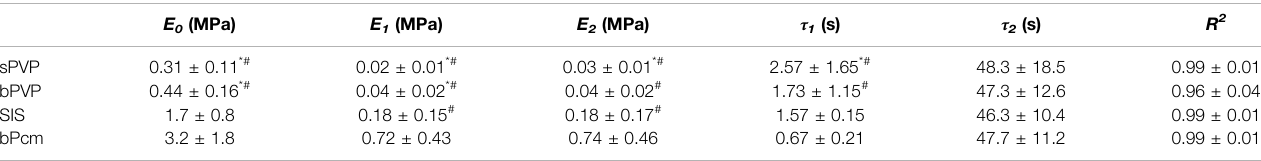
TABLE 3 | Viscoelastic parameters of the tissues ’ best fi t with the Maxwell – Wiechert model. E 0 (MPa) E 1